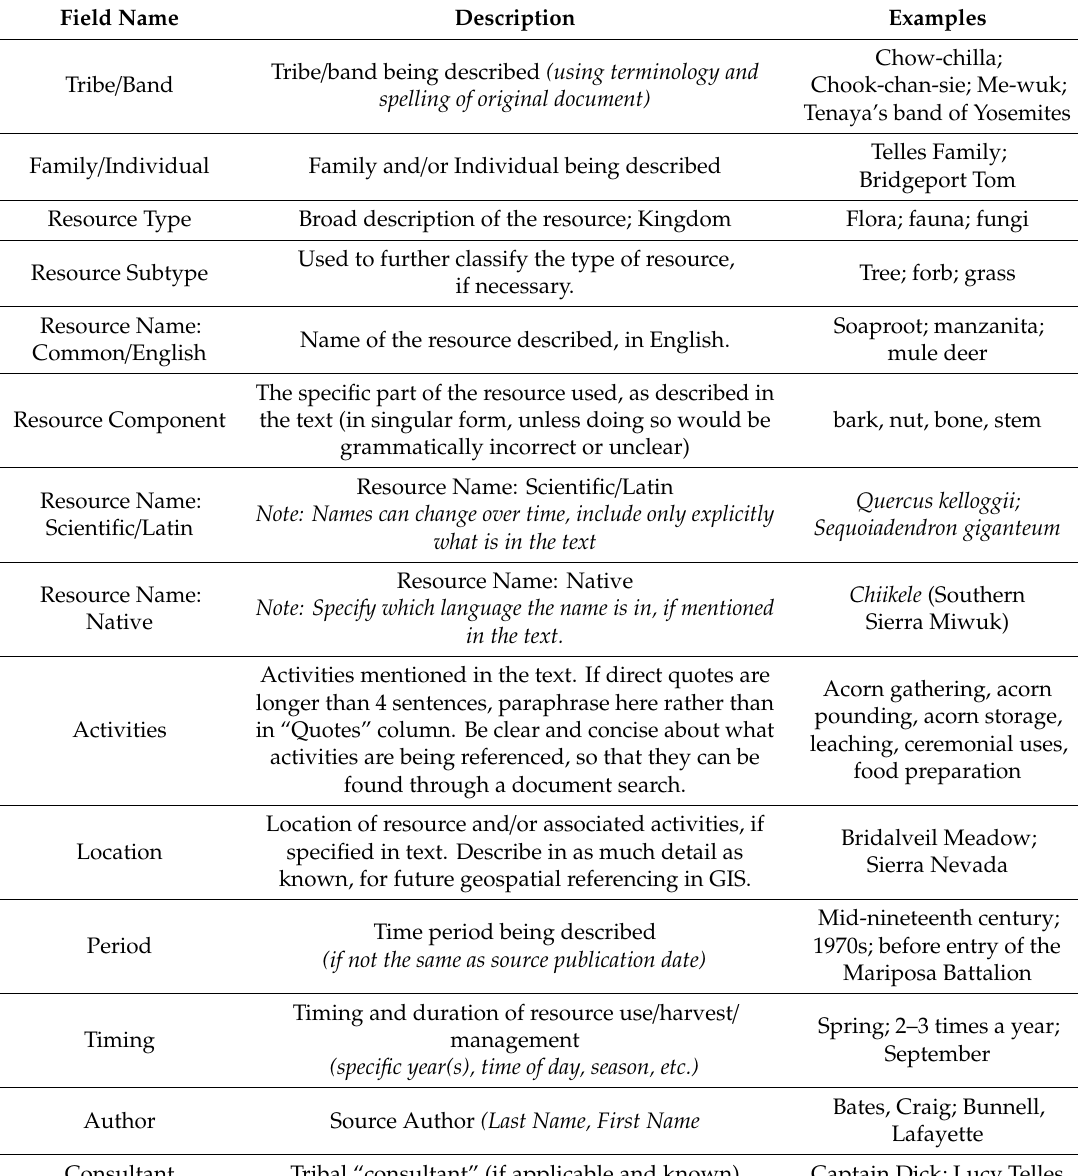
Table 1. Excerpt from Ethnographic Database Metadata with Description of Field Content